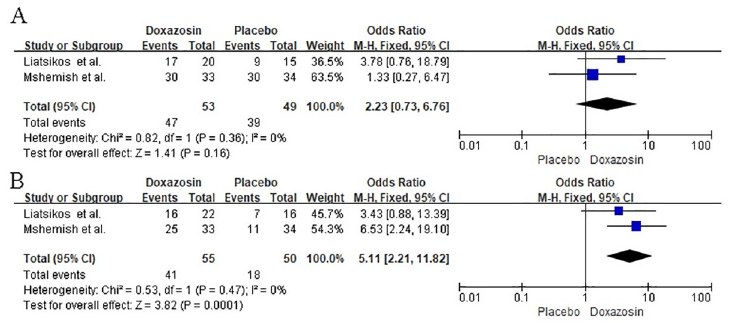
Fig 5. A: Meta-analysis results of expulsion rate (stones size < 5mm) between the groups. B: Meta-analysis results of expulsion rate (stones size 5-10mm) between the